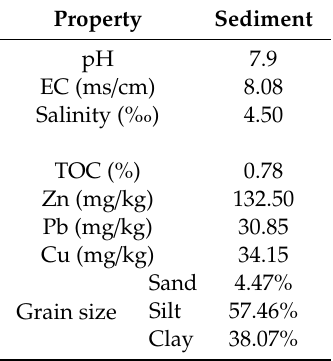
Table 1. The physicochemical properties of the marine sediments. EC: electrical conductivity, TOC: total organic